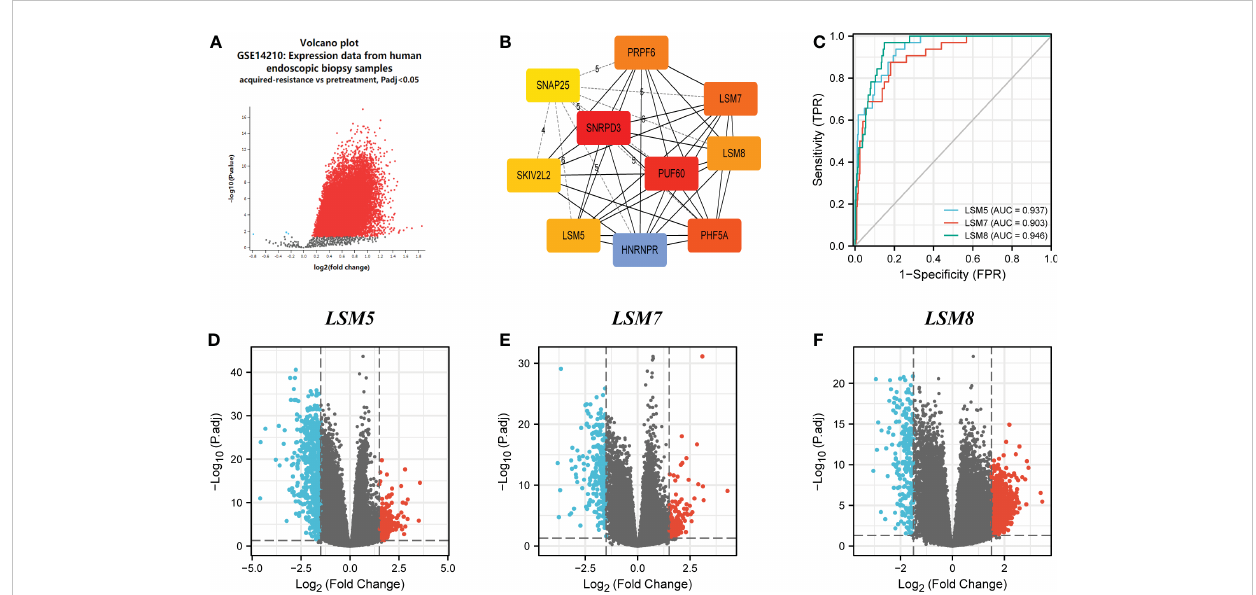
FIGURE 5 Differential expression analysis and the predictive value of LSM5, LSM7 and LSM8 in GC. (A) Volcano plots of the differentially expressed genes (DEGs) screened by GEO2R in GSE14210 from GEO database. (B) the top 10 hub genes of above upregulated DEGs by MCC degree from STRING and Cytoscape. (C) Receiver operating characteristic (ROC) curve for LSM5, LSM7 and LSM8 expression in GC by the pROC package by the pROC package. (D – F) Volcano plots of DEGs of LSM5, LSM7 and LSM8 in GC from TCGA database.